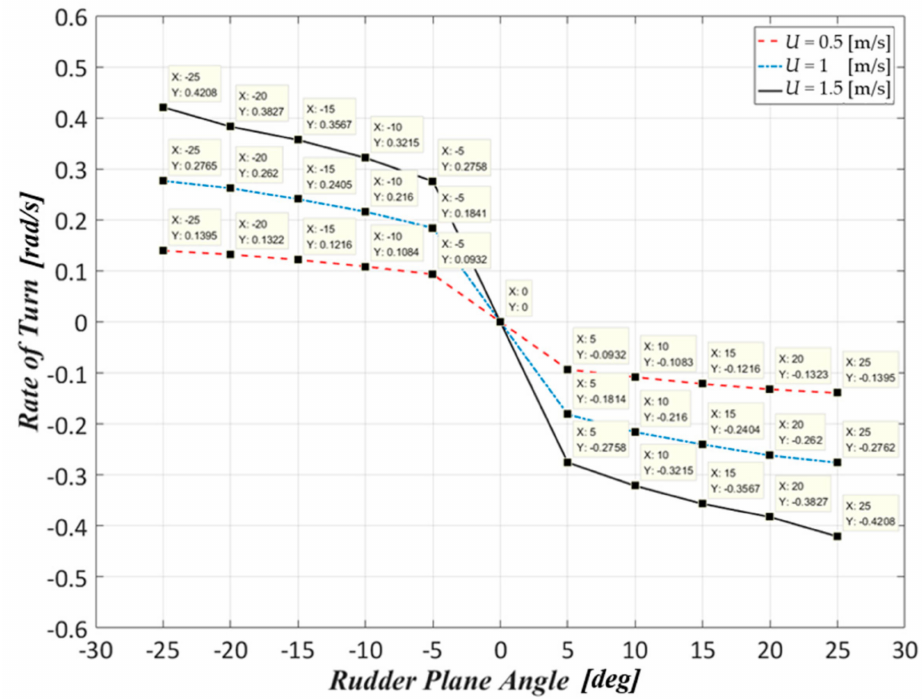
Figure 17. Relationships between the yaw rates and the rudder plane angles at different sailing speeds for the spiral